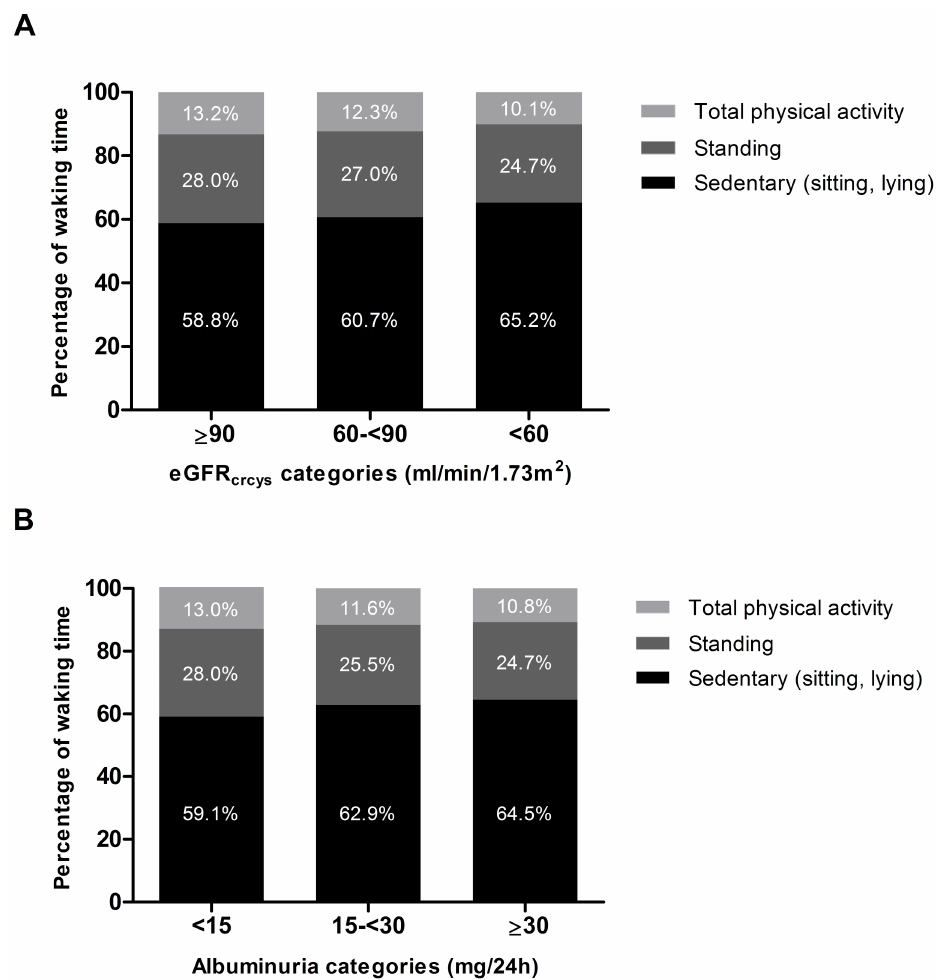
Fig 1. Percentage of waking time spent sedentary, standing, and physically active according to categories of eGFR crcys (panel A) and albuminuria (panel B). Distribution of participants in the eGFR crcys categories: (cid:21) 90 ml/min/ 1.73m 2 n = 1073, 60- < 90 ml/min/1.73m 2 n = 1077, < 60 ml/min/1.73m 2 n = 97. Distribution of participants in the albuminuria categories: < 15 mg/24h n = 1804, 15- < 30 mg/24h n = 246, (cid:21) 30 mg/24h n = 197.